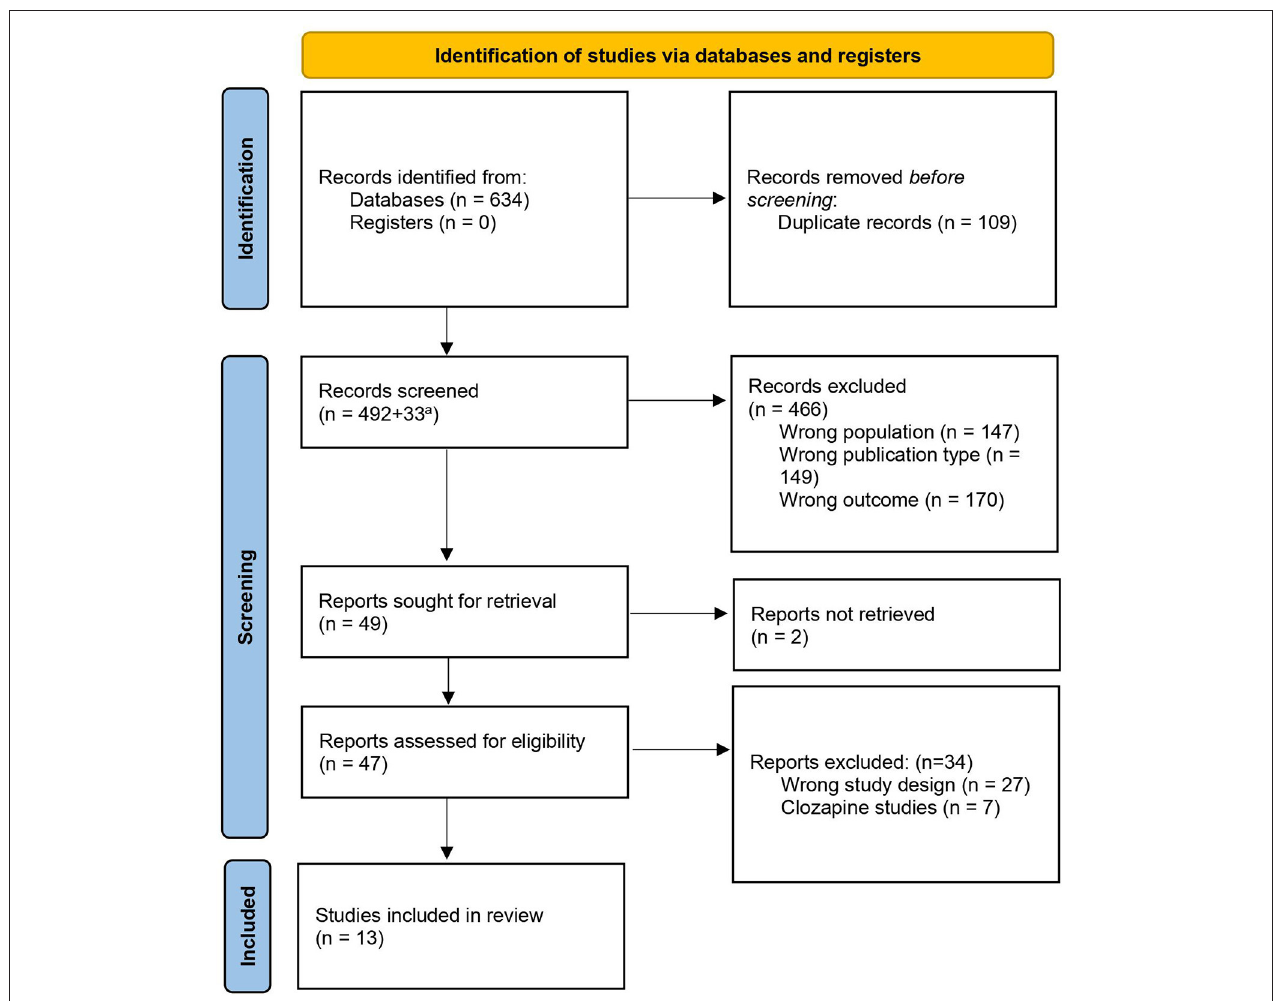
FIGURE 1 | PRISMA flow diagram of the literature search and the selection process [diagram adapted from (18)]. a Additional records added after repeated search on 07.06.2021.